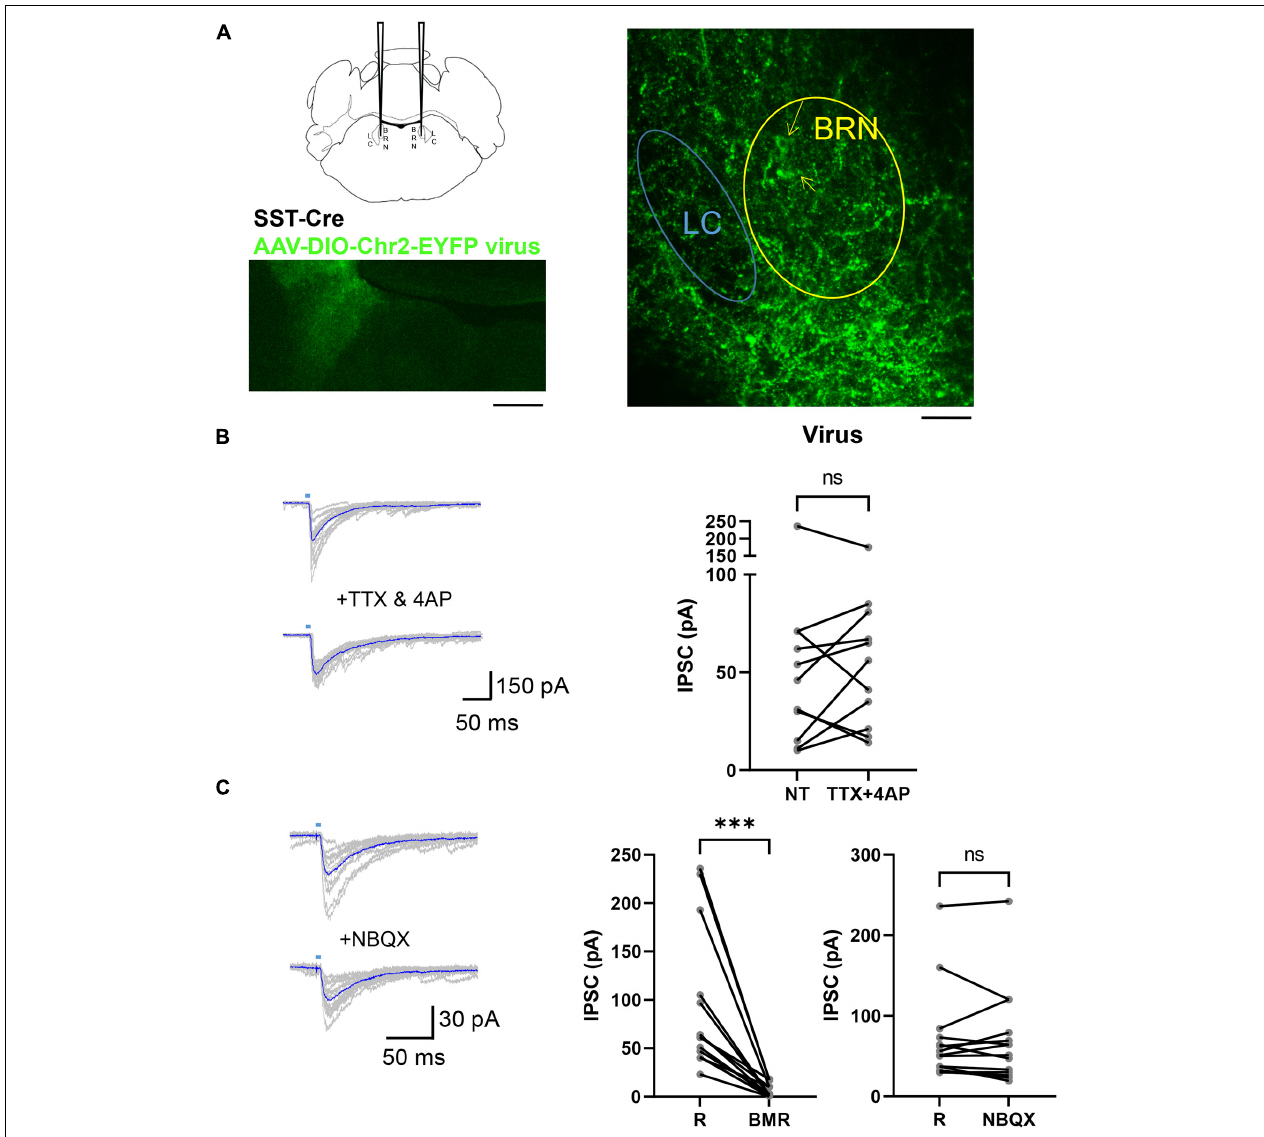
FIGURE 3 | AAV DIO ChR2 Virus injections in the Pons of Sst Cre mice. (A) Sst Cre mice were injected in the pontine region, labeled BRN in the schematic ( left, top ), with a cre -dependent virus. Low magnification illustration of the resulting ChR2-EYFP expression ( left, bottom ) in the BRN 3 weeks after injection of AAV-EF1a-DIO-EYFP virus that expresses EYFP in cre expressing neurons ( right ). Yellow arrows point at the soma of YFP expressing SST + neurons in BRN. The location of LC was verified by the presence of a cluster of larger neurons in DIC as in Figure 1 and the location of TH staining. Scale bar = 200 µ m and 100 µ m. (B) To the left are superimposed examples of current traces of light-evoked synaptic currents in a LC neuron voltage clamped at –60 mV recorded in an AAV-EF1a-DIO-EYFP virus injected mouse before ( top ) and during ( bottom ) the application of TTX (1 µ M) and 4AP (30 µ M). Traces in blue are averages of at least 10 repetitive light stimulations. To the right is a paired before-after plot of light-evoked IPSC in the absence (R) and the presence of TTX + 4AP ( n = 3 mice, 11 cells; R: 58 ± 19; TTX + 4AP: 60 ± 14) mean ± SEM. ns, not significant. Wilcoxon matched-pairs signed rank test. (C) Example current traces from voltage clamped LC - neurons in an AAV-EF1a-DIO-EYFP virus injected mouse in the absence ( top ) or presence ( bottom ) of perfusion with NBQX at –60 mV. Paired before-after plots of light-evoked IPSC in the absence (R) and the presence of BMR ( middle , n = 4 mice, 14 cells; R: 92 ± 20 pA; BMR: 6 ± 2 pA) and the absence (R) and presence of NBQX ( right , n = 4 mice, 14 cells; R: 72 ± 16 pA; NBQX: 70 ± 16) mean ± SEM. *** p ≤ 0.001; ns, not significant. Wilcoxon matched-pairs signed rank test.